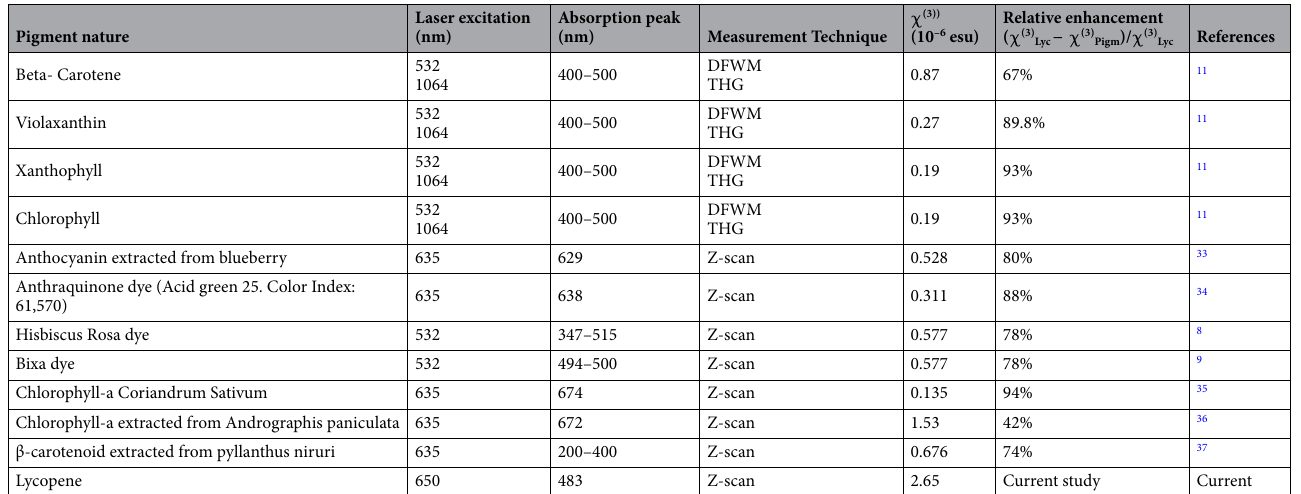
Table 2. NLO 3rd order susceptibility χ (3) of various carotenoids and natural extracts published in the last